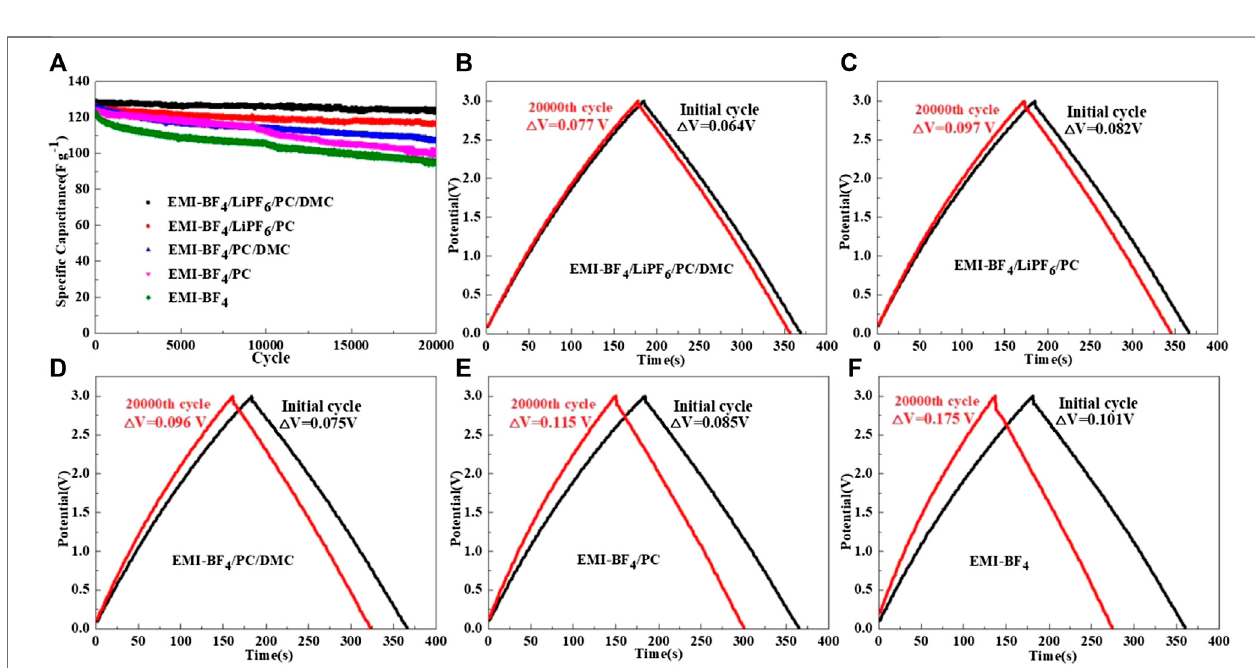
FIGURE 4 | (A) Cycle performances of the EDLCs in various electrolytes at a current density of 1 A g − 1 ; Charge-discharge pro fi les of the EDLCs in (B) EMI-BF 4 /